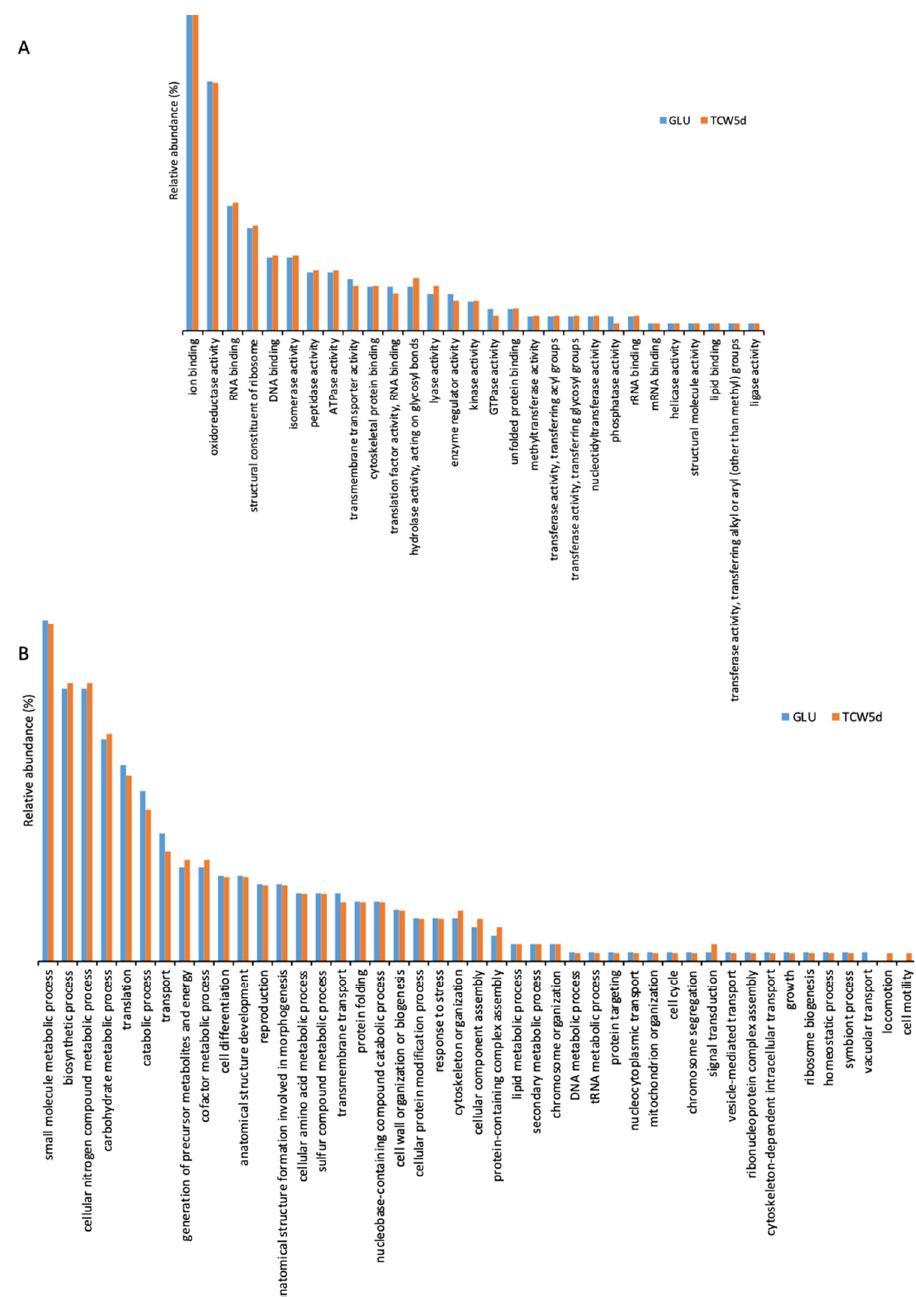
Figure 4. Gene ontology categorization of the identified surfactome proteins by their molecular function ( A ) and their involvement in specific biological processes ( B ).